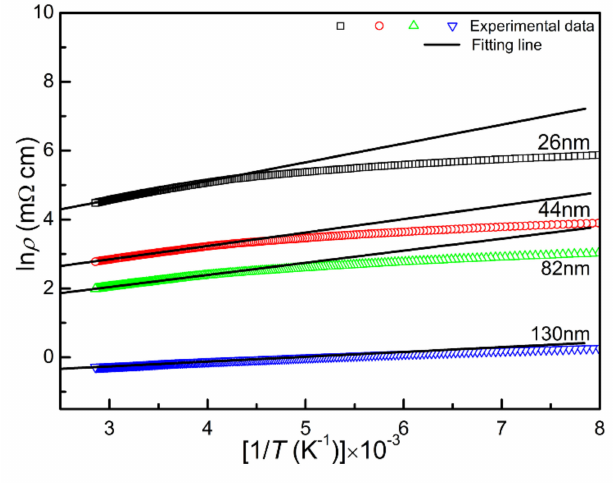
Figure 9. The electrical transport properties fitting results of the derived CrN thin films in the region above T K .